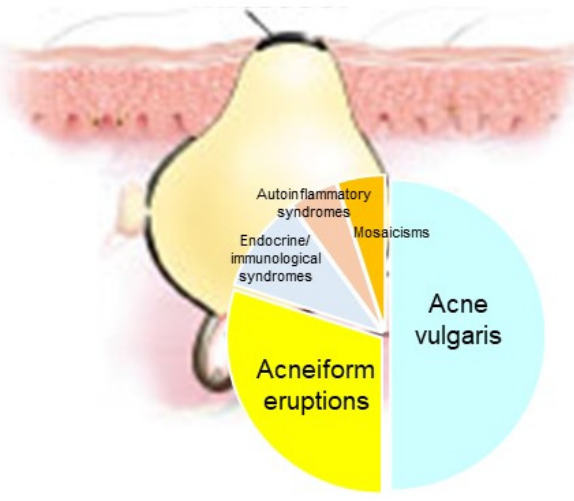
Figure 8. Acne represents a cardinal skin manifestation in several groups of diseases, such as acne vulgaris, acneiform eruptions (acneiform dernatoses), endocrine/immunological syndromes, auto-inflammatory syndromes and certain mosaicisms.